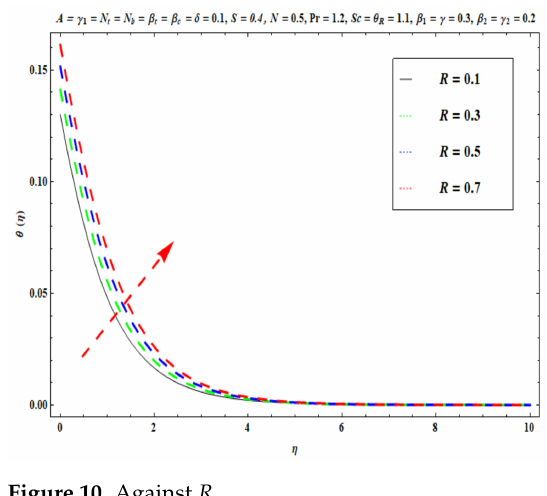
Figure 10. Against R .